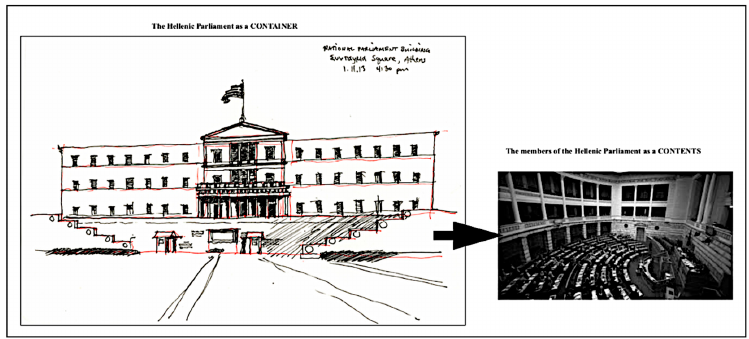
Figure 1. The PART FOR WHOLE image schema communicated by the use of the Greek deictic adverb εδώ [here] in political speeches.